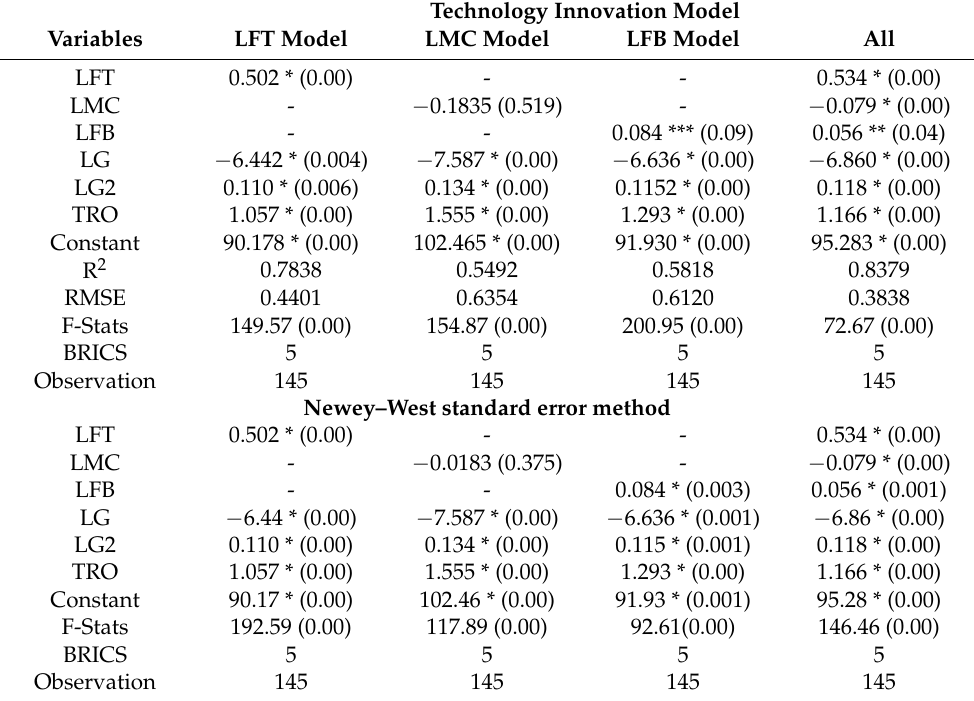
Table 5. Technology innovation